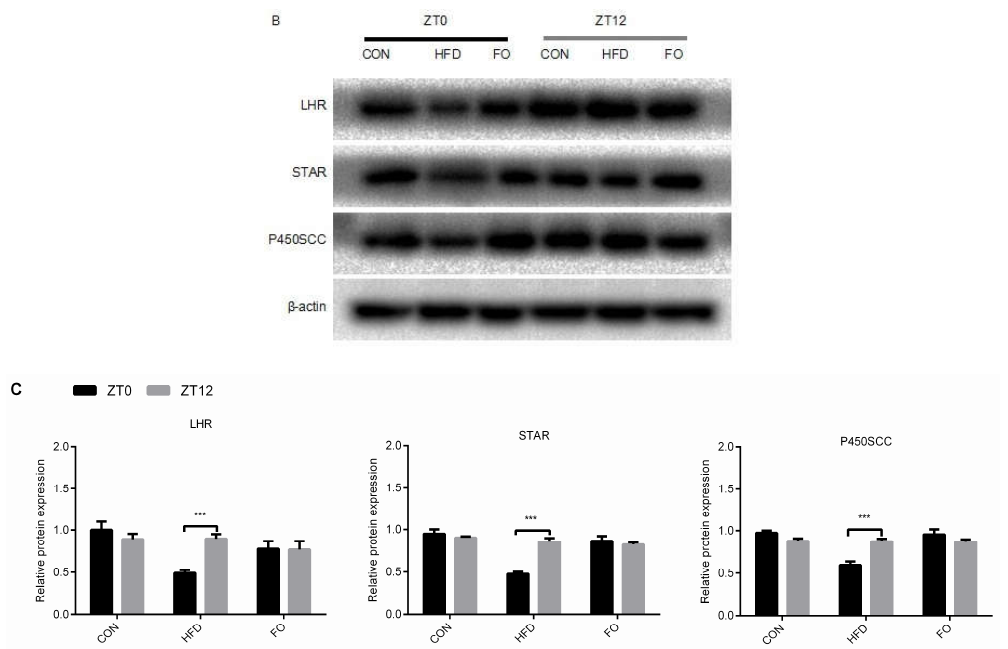
Figure 7. Effect of HFD and FO on the rhythmic expression of some steroidogenic-related genes. ( A )Rhythmic transcription levels analysis of Lhr , Star , P450scc , 3β-Hsd , 17β-Hsd , Sf-1 genes. ( B ) Western blot analysis of LHR, STAR, P450SCC expression in testes. ( C ) Expression levels of LHR, STAR and P450SCC were quantitatively analyzed with Image Lab software. Data were expressed as mean ± SD ( n = 10 per group). * p < 0.05, ** p < 0.01, *** p < 0.001.